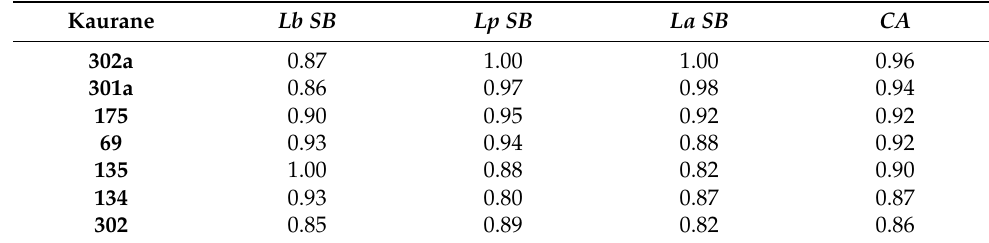
Table 4. Kauranes classified as active using an approach combining ligand-based and structure- based VS.